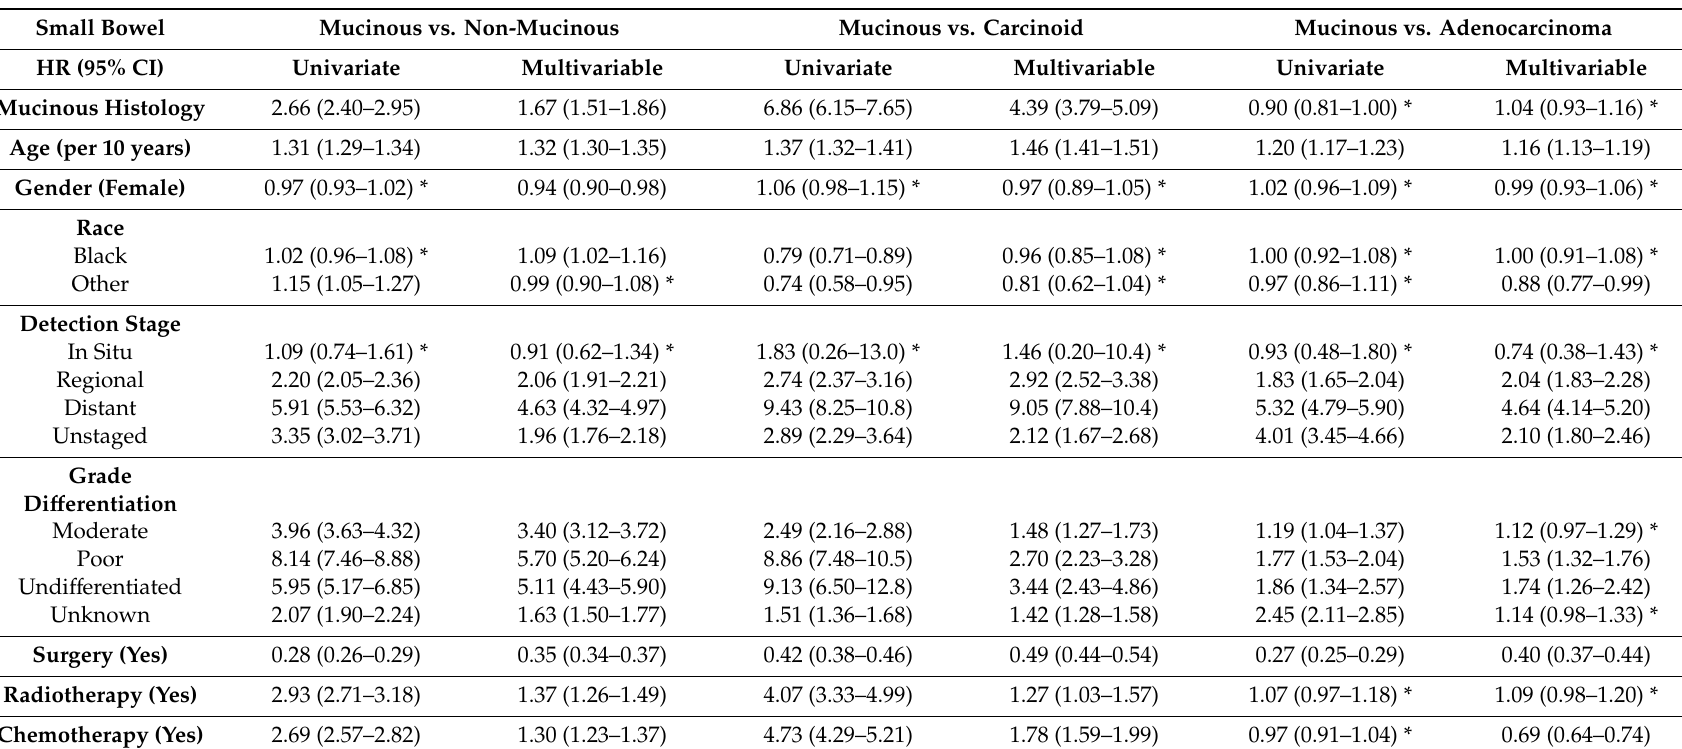
Table 18. Derived univariate and multivariable Cox-proportional hazard ratios (HR) of mortality for small bowel